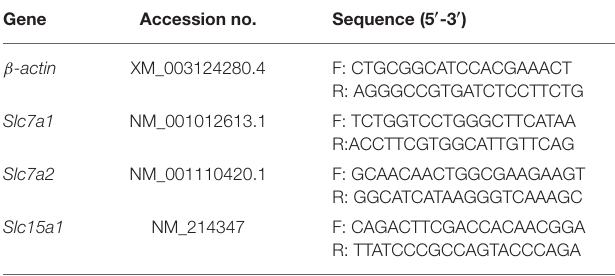
TABLE 1 | Primers used for quantitative reverse transcription